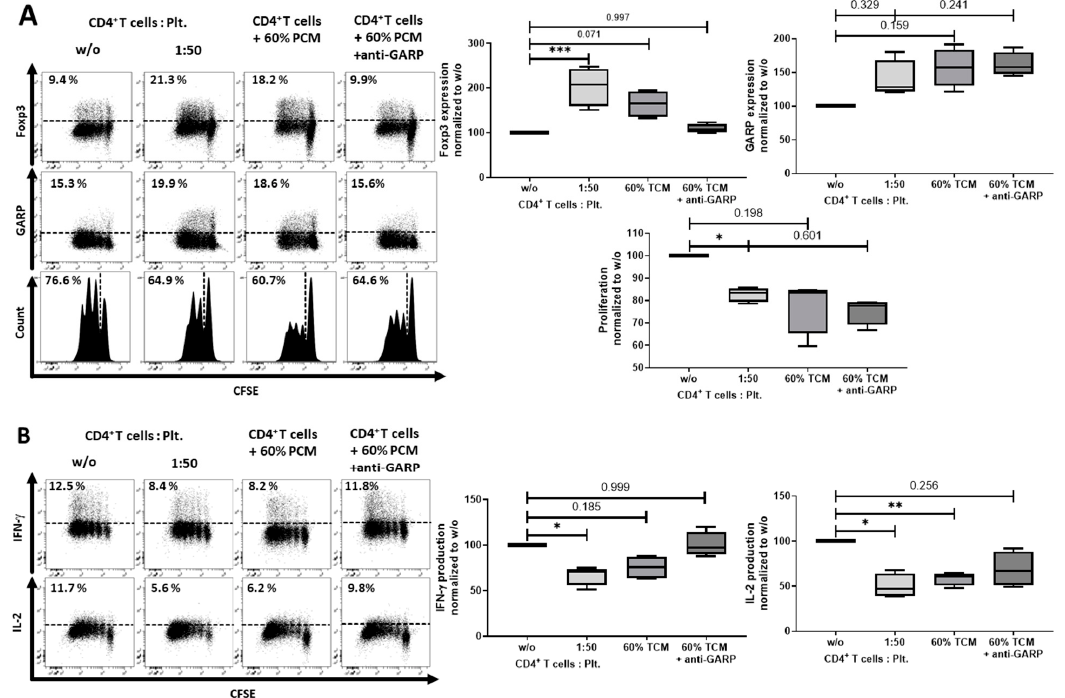
Figure 7. Platelet-conditioned medium (PCM) inhibited IFN- γ production, but failed to induce a Treg phenotype. ( A ) CD4 + CD25 − T cells were cultured in X-Vivo 15 (Lonza, Basel, Switzerland) with 60% PCM content, with or without 10 µ g / mL anti-GARP Ab and stimulated with 0.5 µ g / mL anti-CD3 mAb and 1.0 µ g / mL anti-CD28 mAb. Antibodies were added at day 0. The expression of Foxp3, GARP and cell proliferation were determined at day 3 with flow cytometry. ( B ) Cytokine production of IL-2 and IFN- γ was measured by intracellular flow cytometry on day 6. Dot plots show one representative result of five independent experiments ( n = 5, box and whiskers, medians ± min / max, * p < 0.05, ** p ≤ 0.01, *** p ≤ 0.001, and n.s. determined by one-way